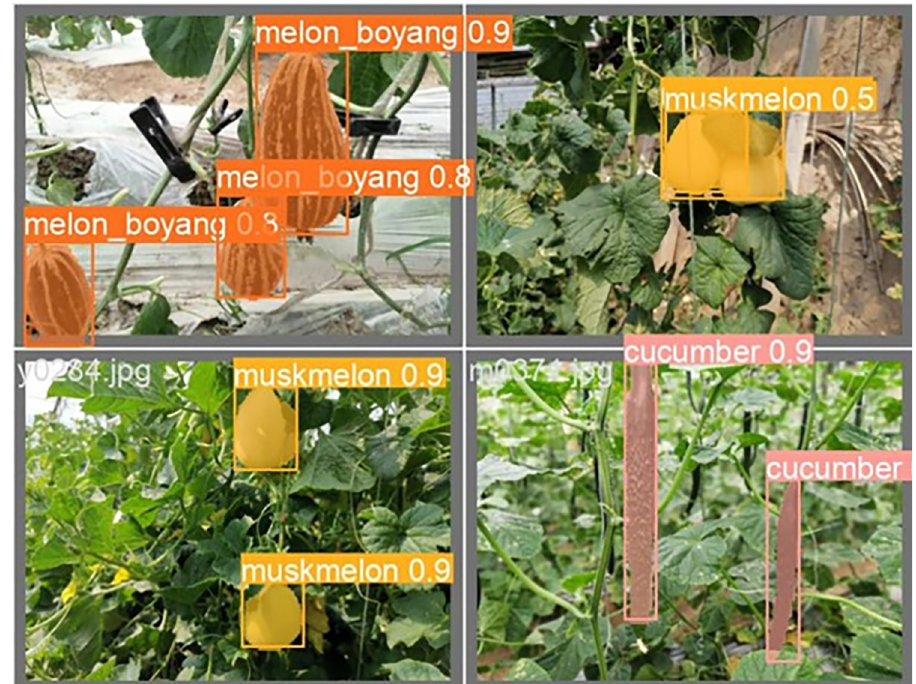
Fig 16. Image results of YOLOv5-LiNetBiFPN.